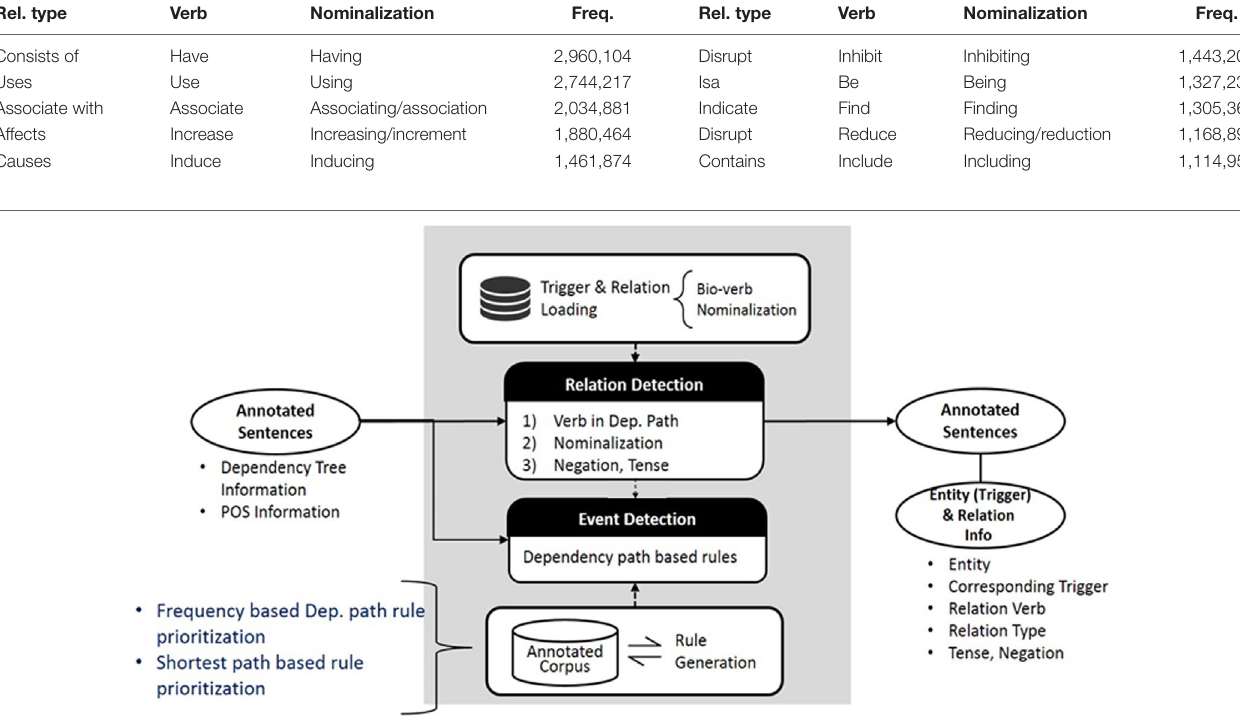
FigUre 4 | Architecture of event detection function.